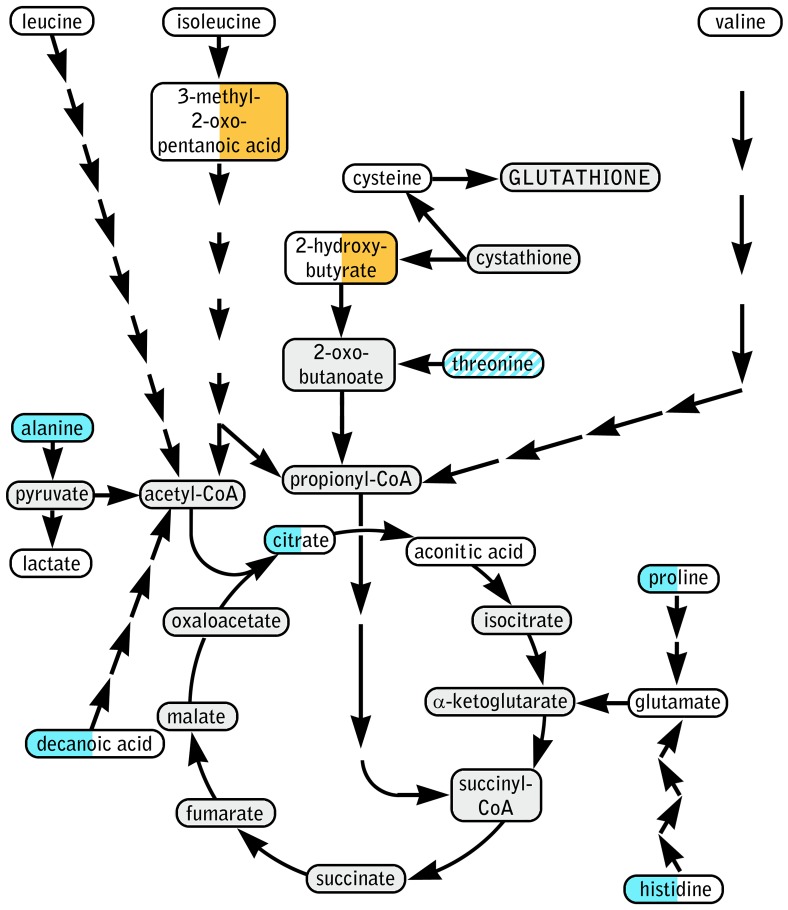
Schematic of implicated metabolic pathways based on metabolomics results (selected metabolites only).Metabolites are inscribed in color coded ellipses with the effect of GBP in left half and effect of SG in right half. Color code: blue, significantly lower; orange, significantly higher; white, no significant effect of bariatric surgery; diagonal stripes, significant effect of surgery but not significant in post-hoc test. Grey highlights an undetected metabolite.